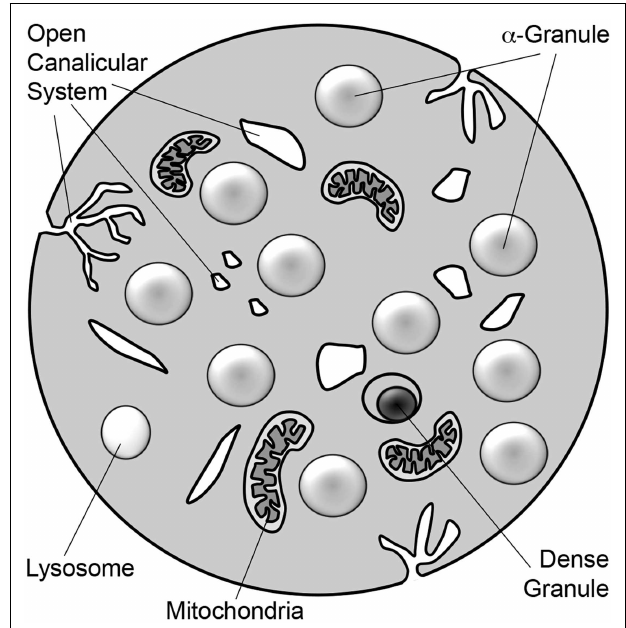
FIGURE 1 | Schematic diagram of platelet .The platelet is a 2–3 µ m discoid cell that contains α -granules, dense granules, and lysosomes. Platelets also contain mitochondria.Tunnel invaginations of the plasma membrane forms a complex membrane network, termed the open canalicular system, that courses throughout the platelet interior. Platelet granule secretion is thought to occur through fusion of granules with either the plasma membrane or the open canalicular system.